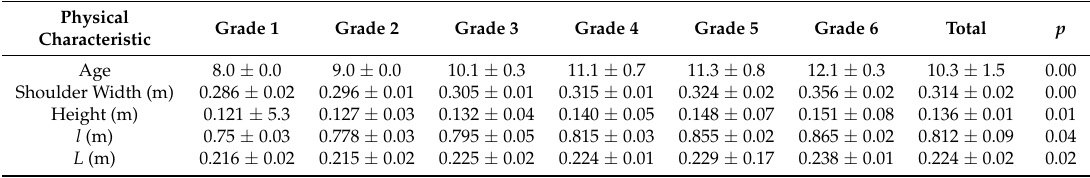
Table 4. Static physical characteristics of the single support phase for each grade student ( n = 12) while standing beside stairs (mean ±